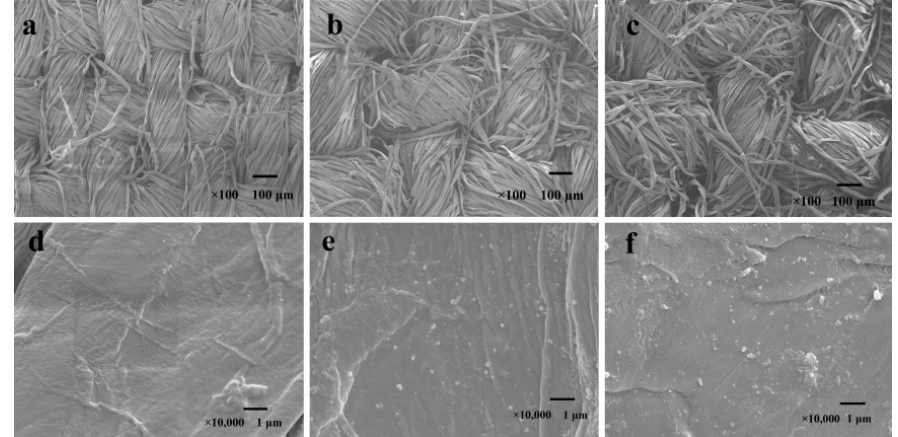
Figure 8. SEM images of Unfinished Cotton ( a , d ), Ag/Cotton ( b , e ) and PMA-CA-Ag/Cotton ( c , f ) were 100 and 10,000 times magnified.